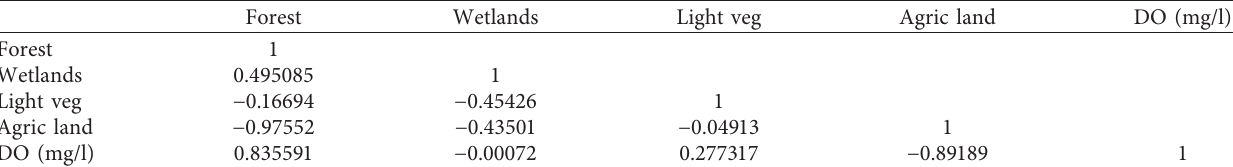
Table 3: Correlation between LULC and DO in the Nyando River basin. Forest Wetlands Light veg Agric